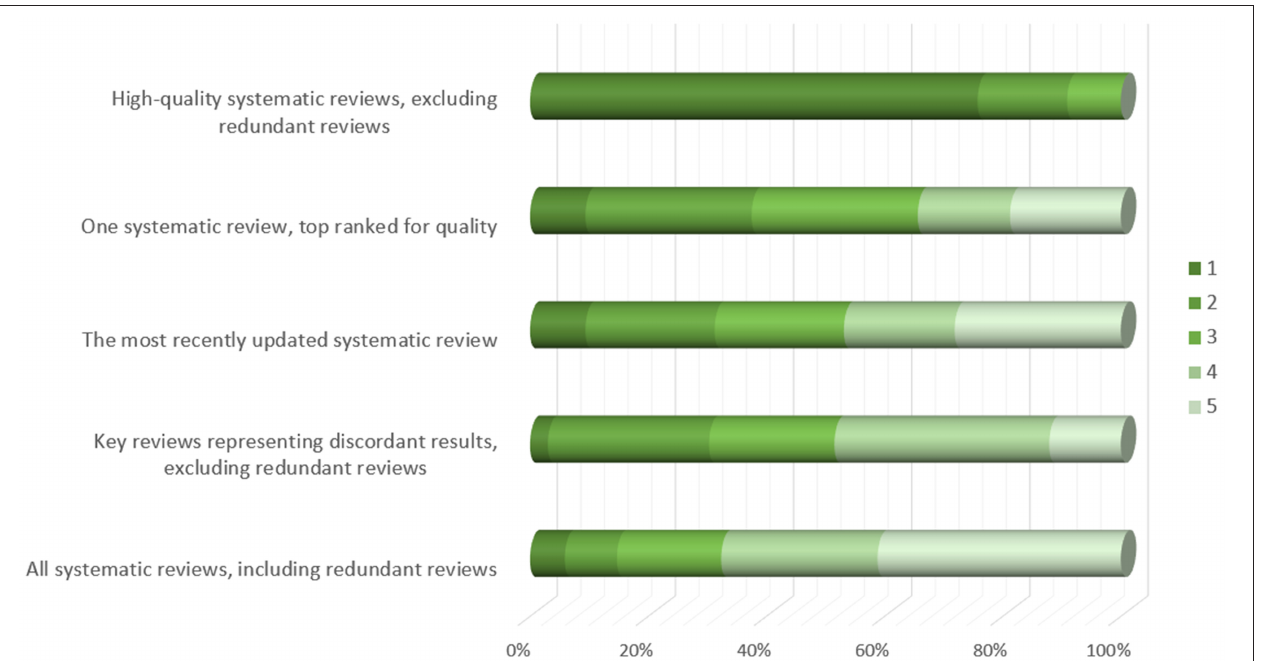
FIGURE 1 | Participants’ opinion about approaches to be taken for supporting guideline development group decisions in case of overlapping meta-analyses (responses provided by 34 participants). Figure shows responses to the following question: Overlapping meta-analyses can often be confusing because they may reach different conclusions. In such cases, which approach could be the most effective in supporting guideline development group decisions? Please order the statements by relevance, the most relevant =